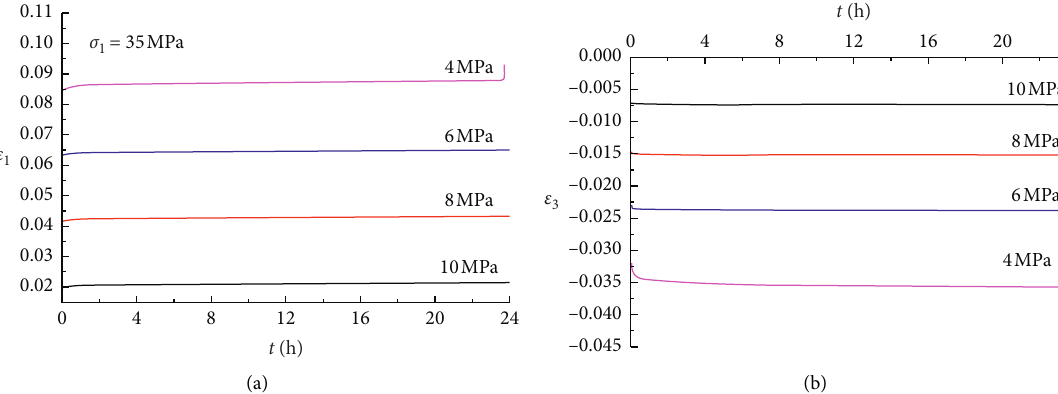
Figure 6: Unloading rheological curve cluster of coal samples with 45 ° fracture angle. (a) Cluster of axial creep curves. (b) Cluster of lateral creep curves.